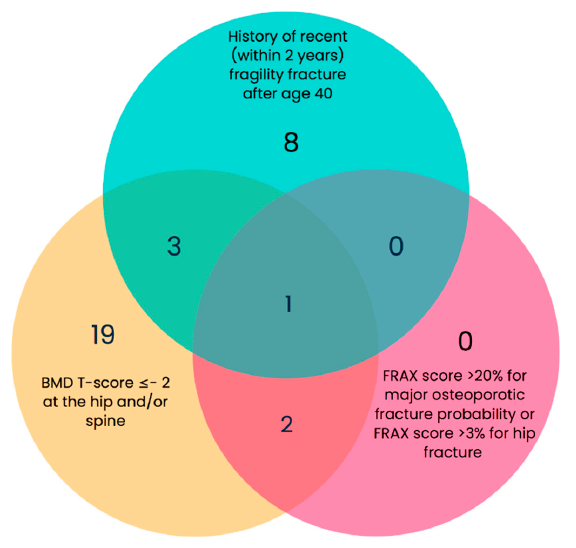
Figure 2. Venn diagram showing the actual number of people with obesity (PwO) for whom anti- osteoporotic medication would be recommended based on the ECTS